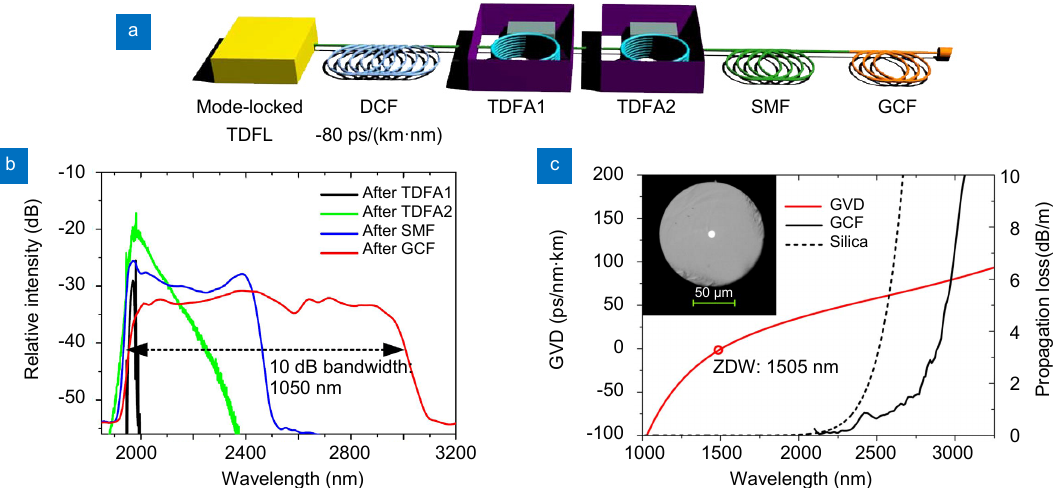
Fig. 8 | ( a ) Experimental setup of supercontinuum generation in germania-core fiber. ( b ) Spectral comparison at different positions. ( c ) Dispersion and loss distribution curve. Figure reproduced from ref. 41